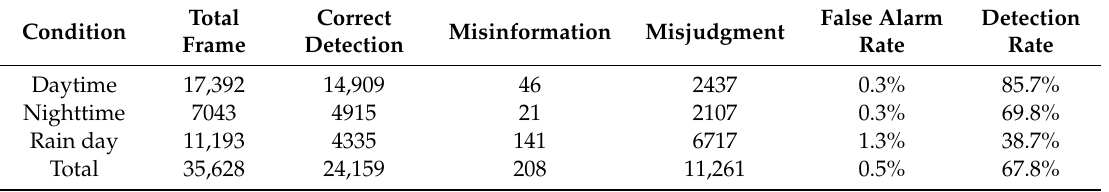
Table 3. Detection results of vision-based systems under the di ff erent weather